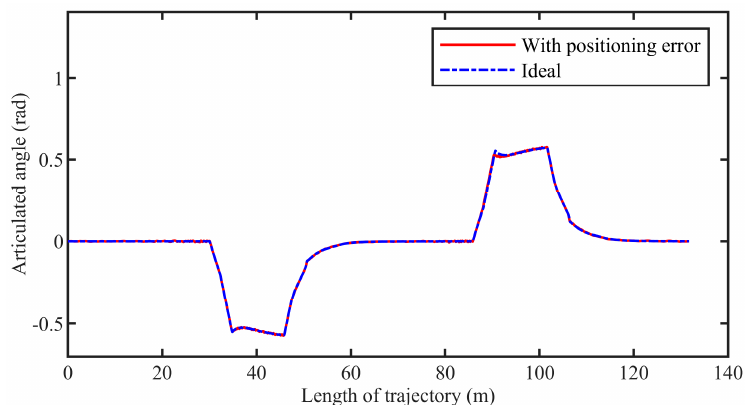
Figure 20. The articulated angle of the simulation with positioning errors.